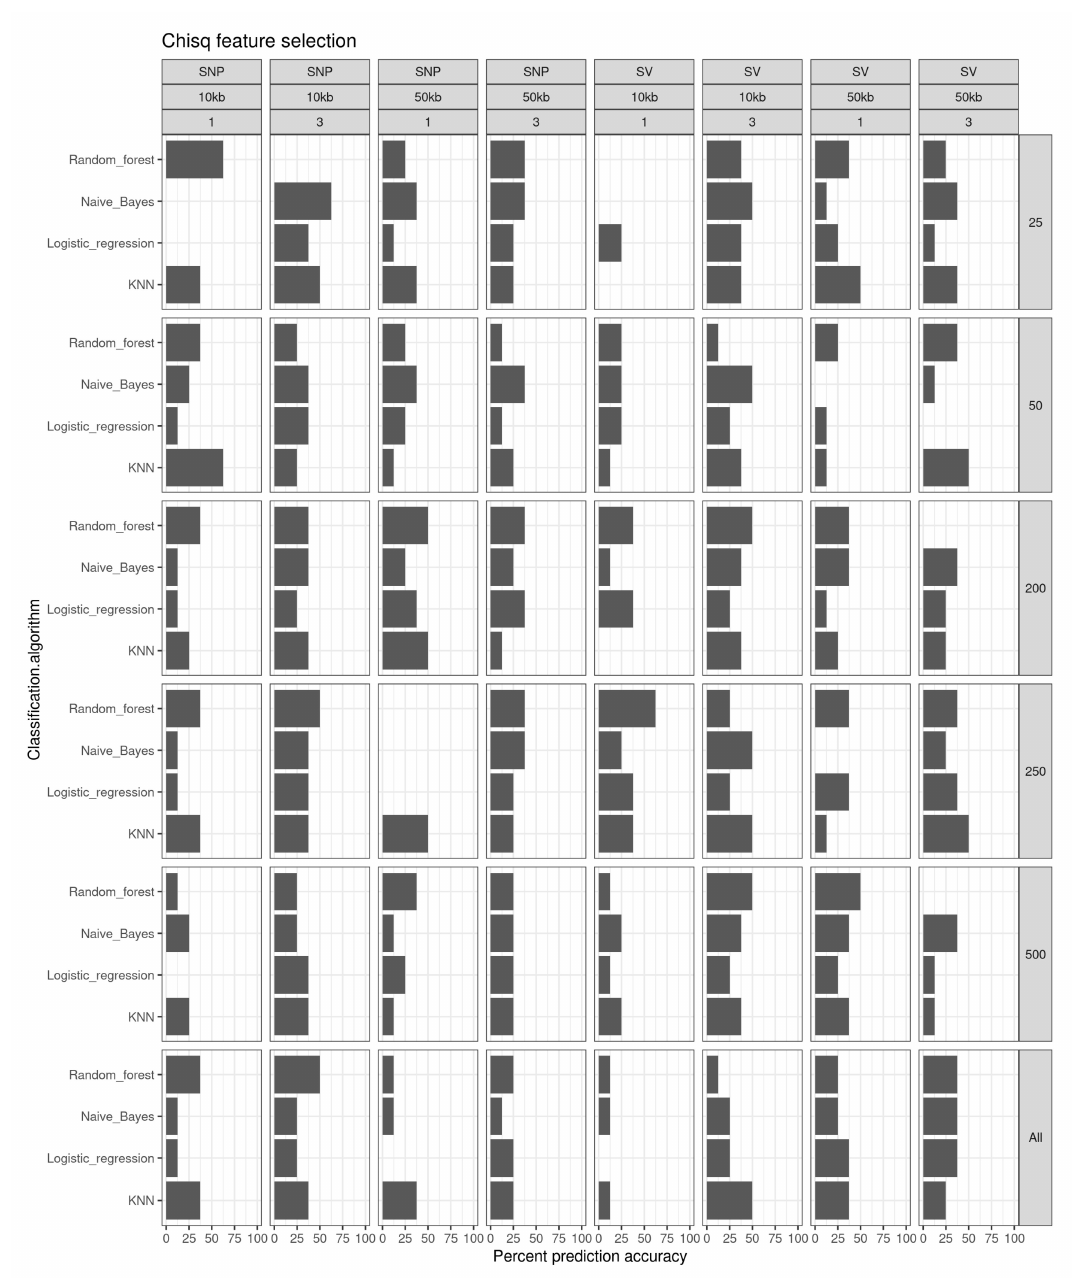
Figure 4. Prediction accuracy (%) for the different feature selection sets of classification algorithm using a Chi-square feature selection